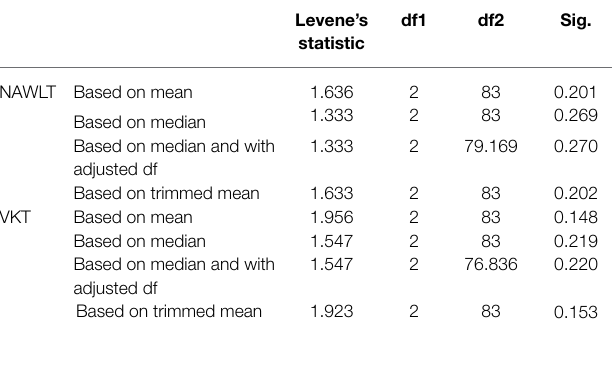
TABLE 5 | Test of homogeneity of variances for scores on post-test.